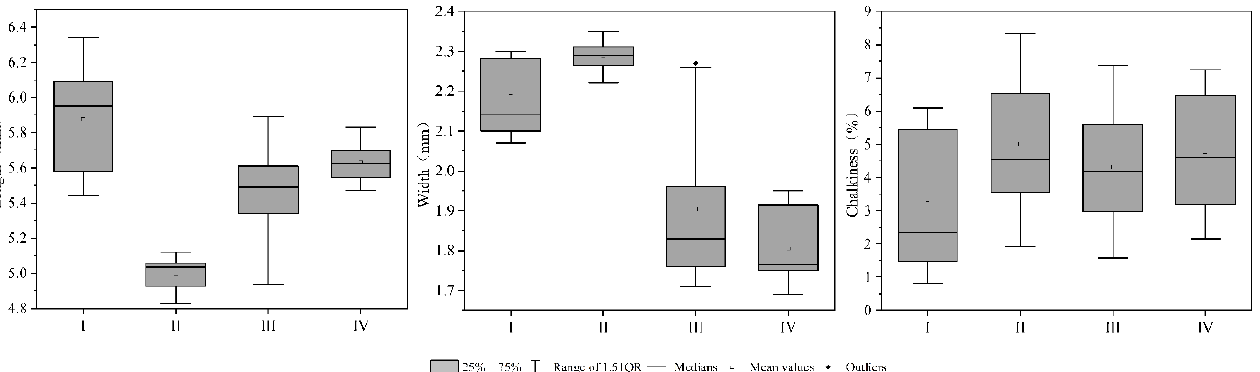
Figure 2. Appearance quality of rice.